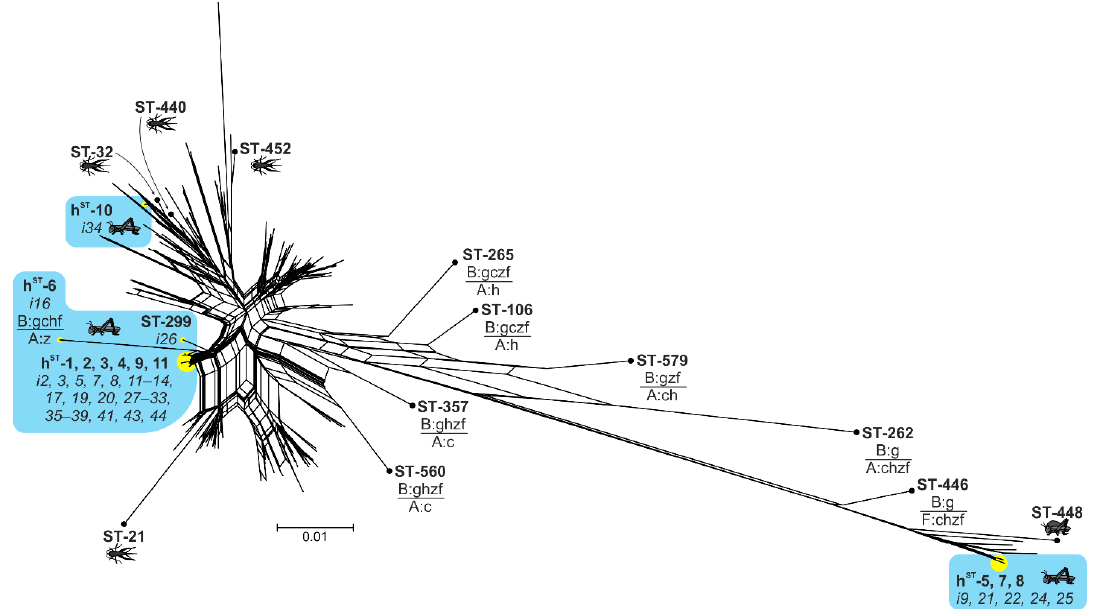
Figure 3. The phylogenetic network (NeighborNet) constructed in SplitsTree4 from 215 unique hap- lotypes (concatenated MLST genes). Branches with isolates from this study are highlighted in yellow. Other haplotype profiles were included here because (1) an Orthoptera host (insect symbol provided) or (2) a haplotype shared at least one identical or closely related allele with the studied Acrididae isolates. Inter-supergroup recombinant haplotypes are designated as ‘supergroup (A, B or F): genes g (gatB), c (coxA), h (hcpA), z (ftsZ), f (fbpA)’. See original files in Supplementary Materials.